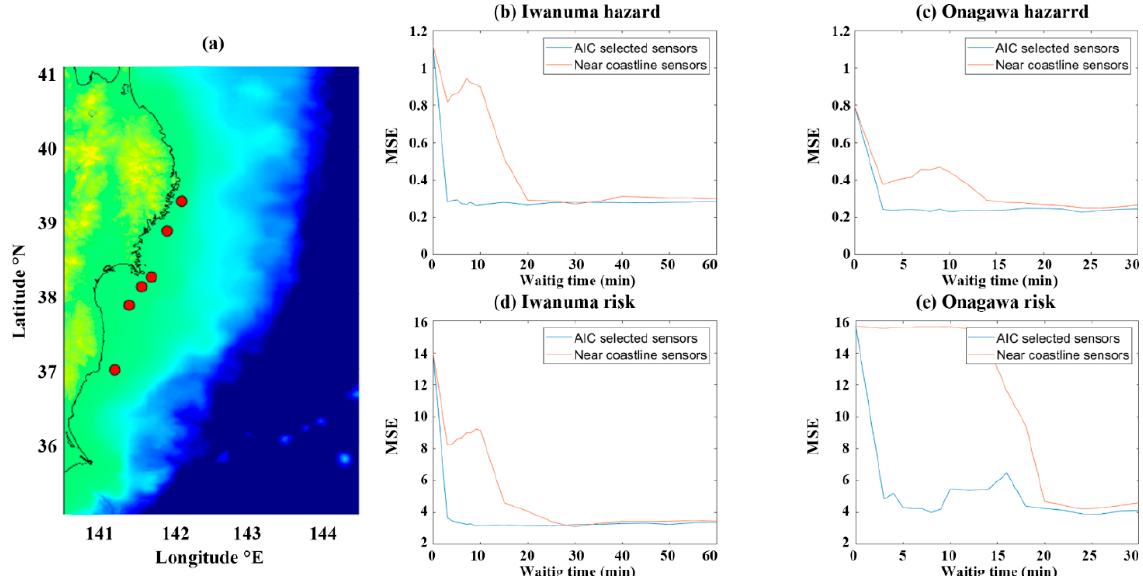
Figure 17. Performance comparison of six near coastline sensors with selected sensors: ( a ) the map of the six near coastline sensors (the red circles represent the selected six near shore sensors), ( b ) MSE for maximum on-shore amplitude in Iwanuma, ( c ) MSE for maximum on-shore amplitude in Onagawa, ( d ) MSE for tsunami loss in Iwanuma, and ( e ) MSE for tsunami loss in Onagawa. In terms of risk-based forecasting, the MSE of the model with AIC-selected sensors decreases significantly in the first 10 min of waiting time and then reaches a flat